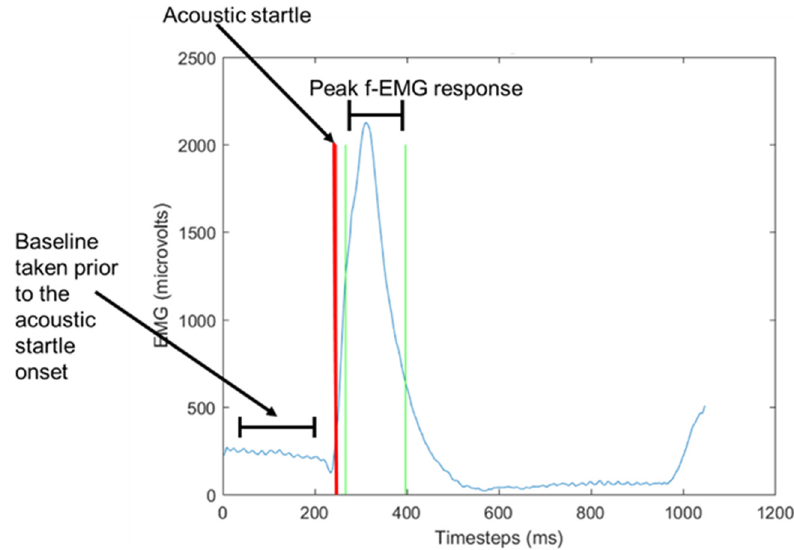
Figure 3. Example f-EMG response .